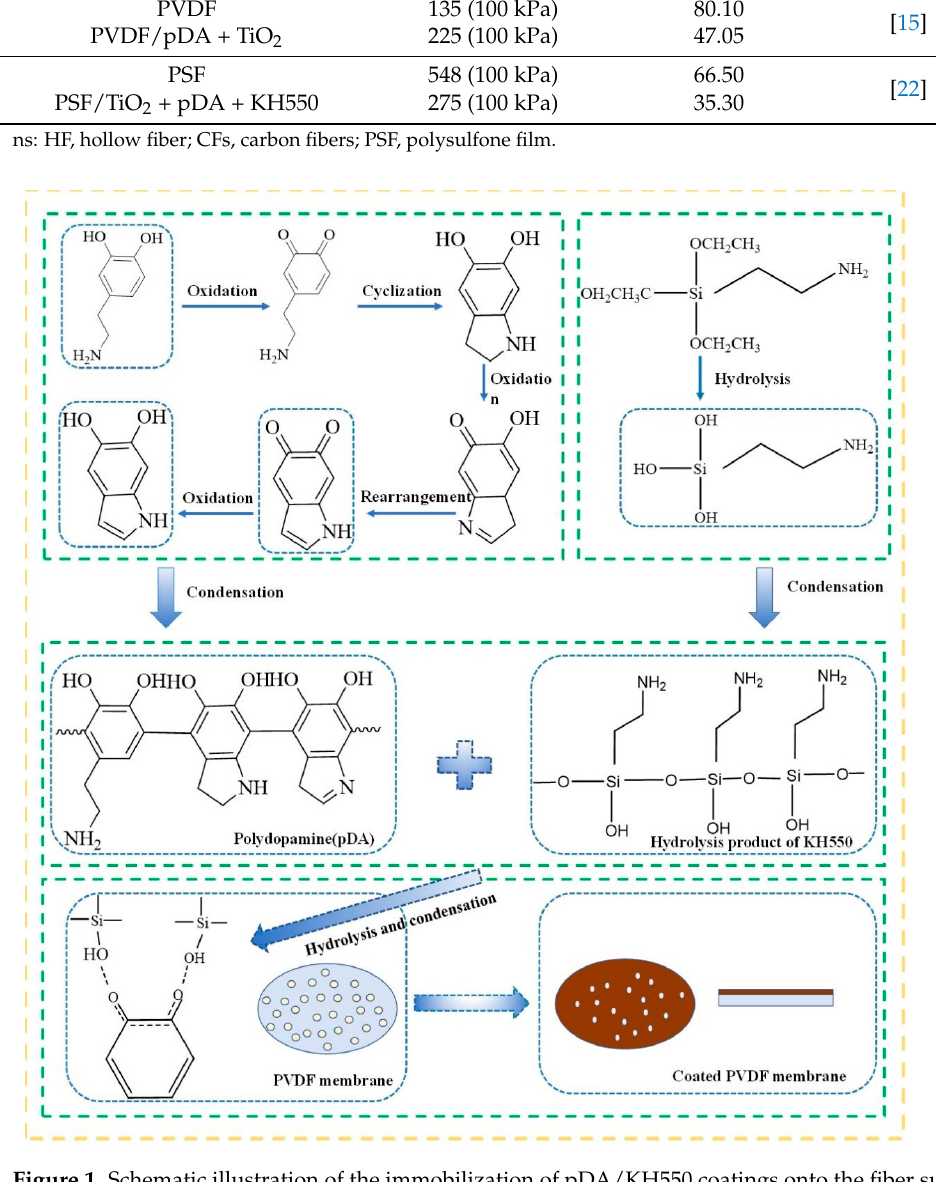
Figure 1. Schematic illustration of the immobilization of pDA/KH550 coatings onto the fiber surface.